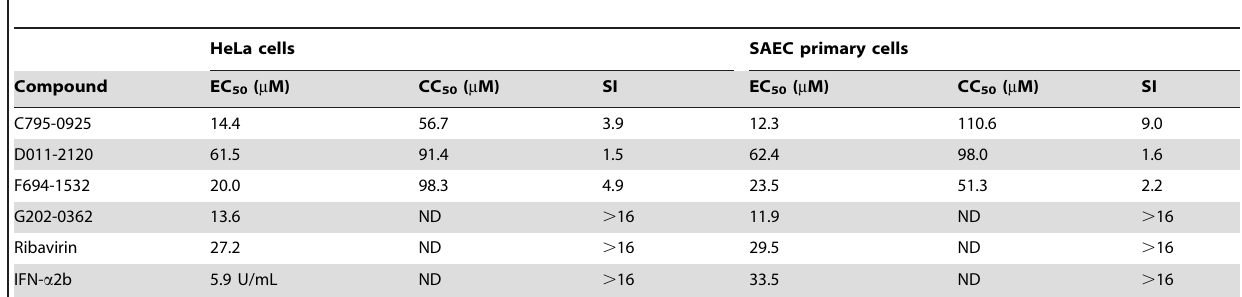
Table 1. Antiviral activity of the four hit compounds and reference compounds against RVFV-infected HeLa cells or SAEC primary